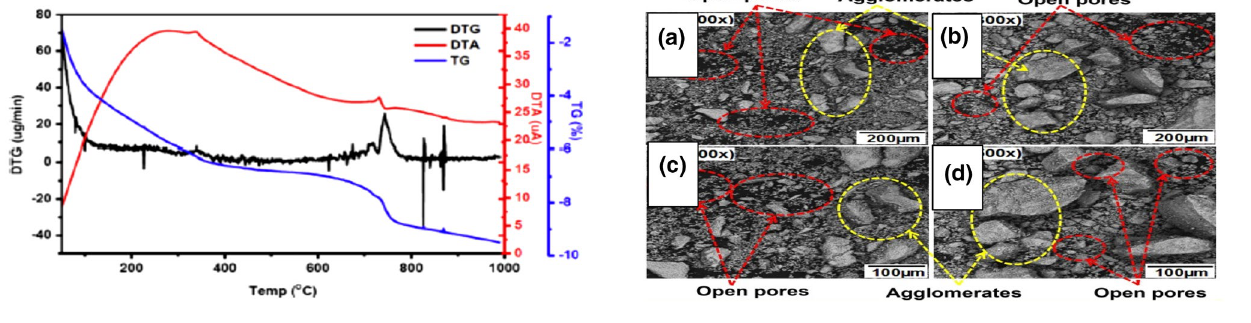
Fig. 9 Typical TG/DTA/DTG of HAp produced by alkaline heat treat- ment [84]